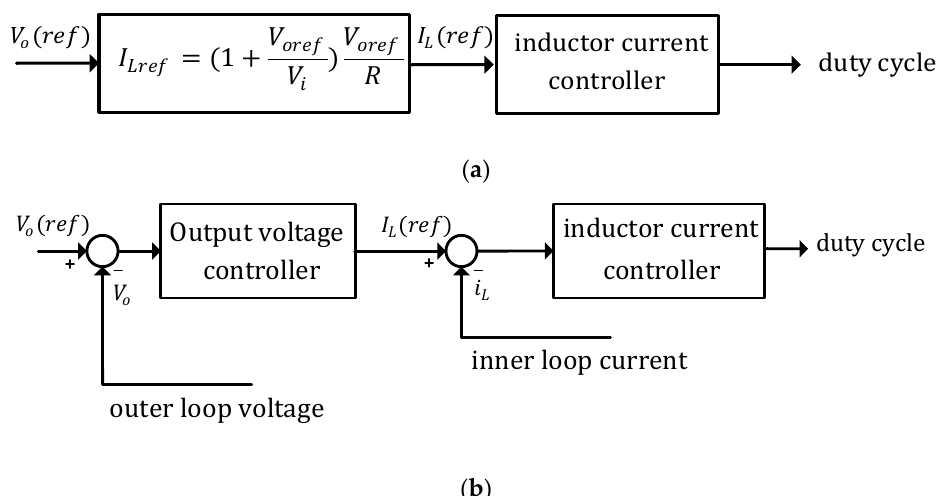
Figure 2. Indirect control of the output voltage. ( a ) Indirect control of the output voltage in non- minimum SMPS. ( b ) Two-loop control of the non-minimum phase SMPS. minimum SMPS. ( b ) Two-loop control of the non-minimum phase